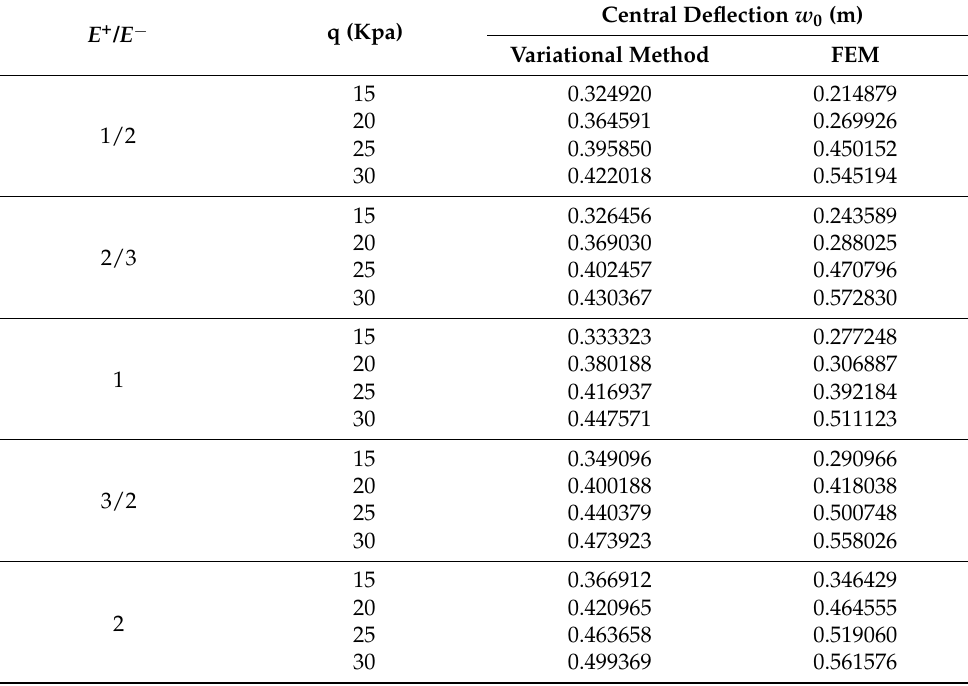
Table 3. Central deflections under different bimodular cases and loads ( Ra 2 / t =